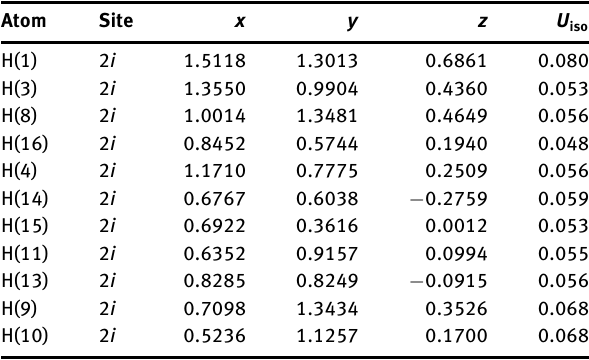
Table 2: Fractional atomic coordinates and isotropic or equivalent isotropic displacement parameters (Å 2